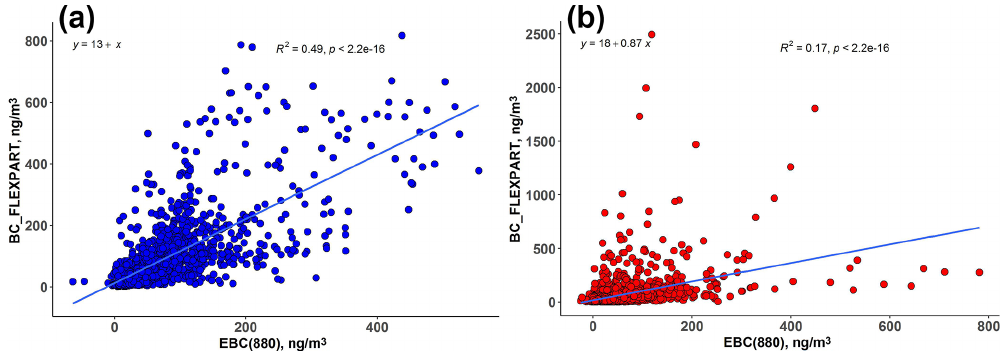
Figure 6. Scatterplots of 3h median measured EBC(880) against modeled BC from FLEXPART for the (a) cold and (b) warm period. Solid line is the linear regression fit of the comparison between modeled and observed